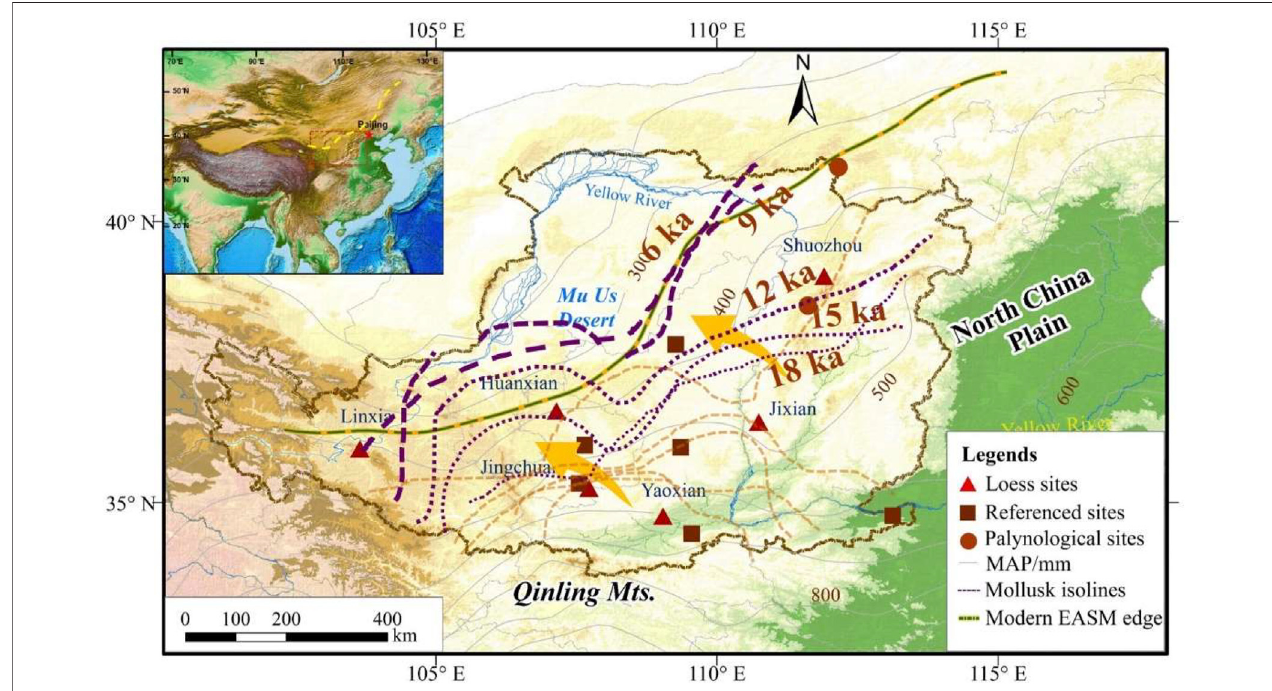
FIGURE 5 | Migration of the East Asian summer monsoon rain belt since the last deglaciation ( ∼ 18 ka, ∼ 15 ka, ∼ 12 ka, ∼ 9 ka, and ∼ 6 ka) reconstructed using the abundance isolines for P. orphana (purple dotted line) and M. angigyra (orange dotted line).